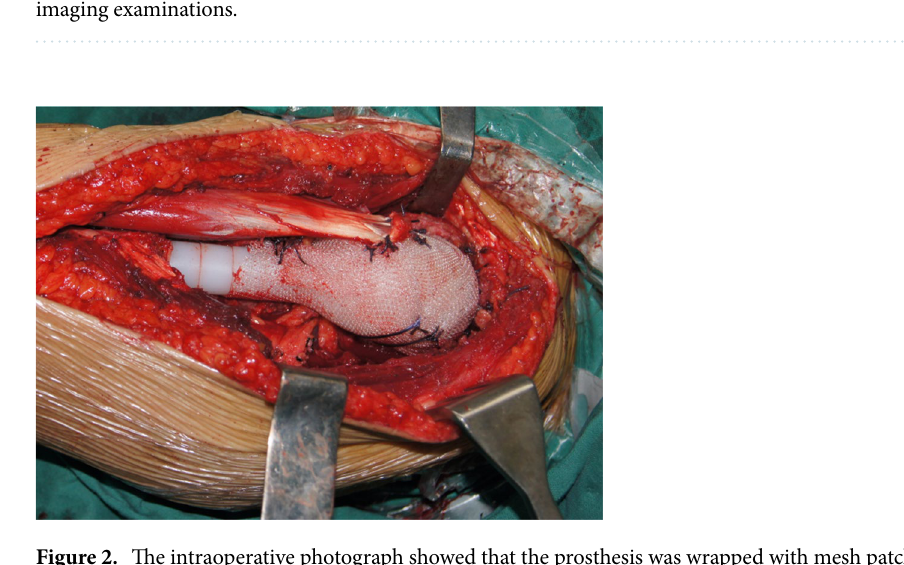
Figure 2. The intraoperative photograph showed that the prosthesis was wrapped with mesh patch to repair the joint capsule and then the surrounding muscles were sutured on mesh